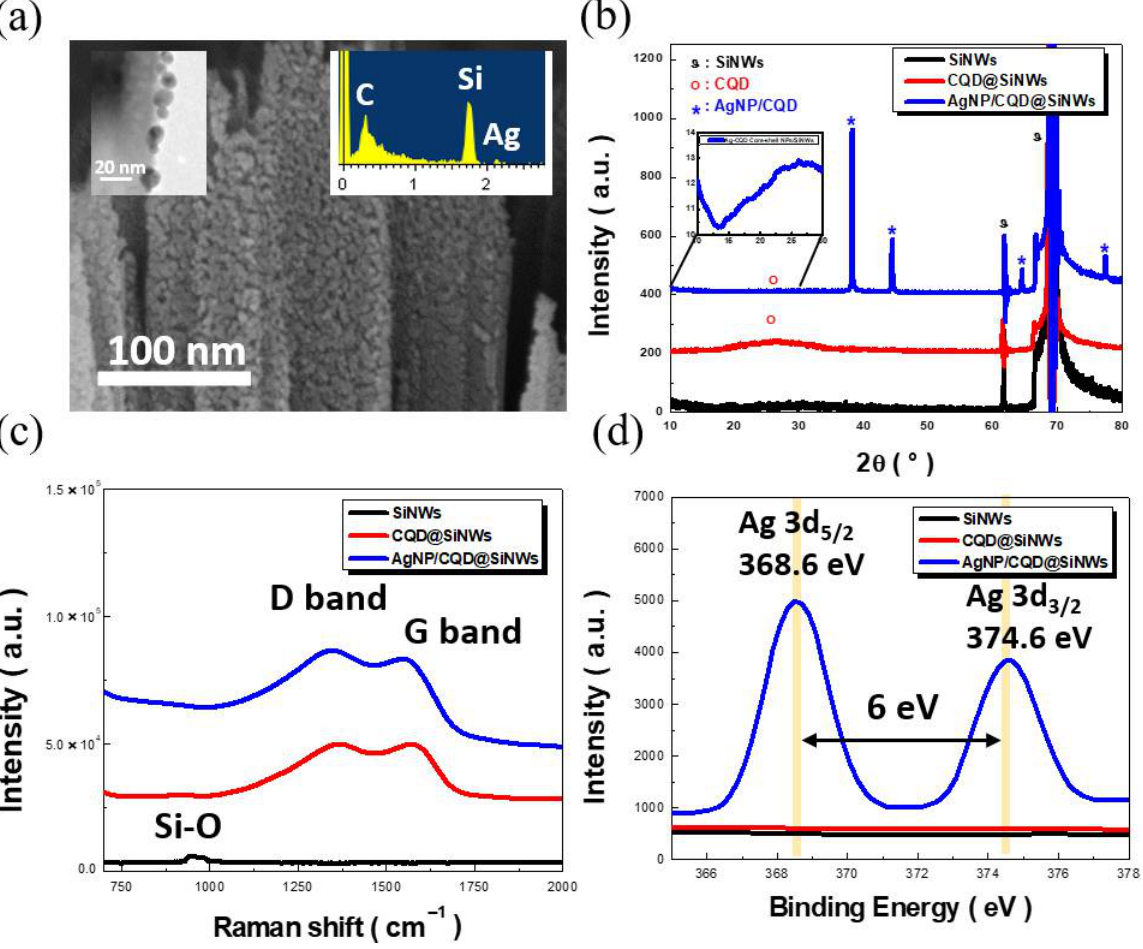
Figure 2. ( a ) Cross-sectional SEM image of CQD/AgNP@SiNW arrays. The inset of Figure 2a shows the corresponding TEM image (figure left) and EDS spectrum (figure right), respectively. ( b ) XRD and ( c ) Raman analysis of three various samples. ( d ) XPS investigations of SiNW, CQD@SiNW and CQD/AgNP@SiNW arrays, respectively.